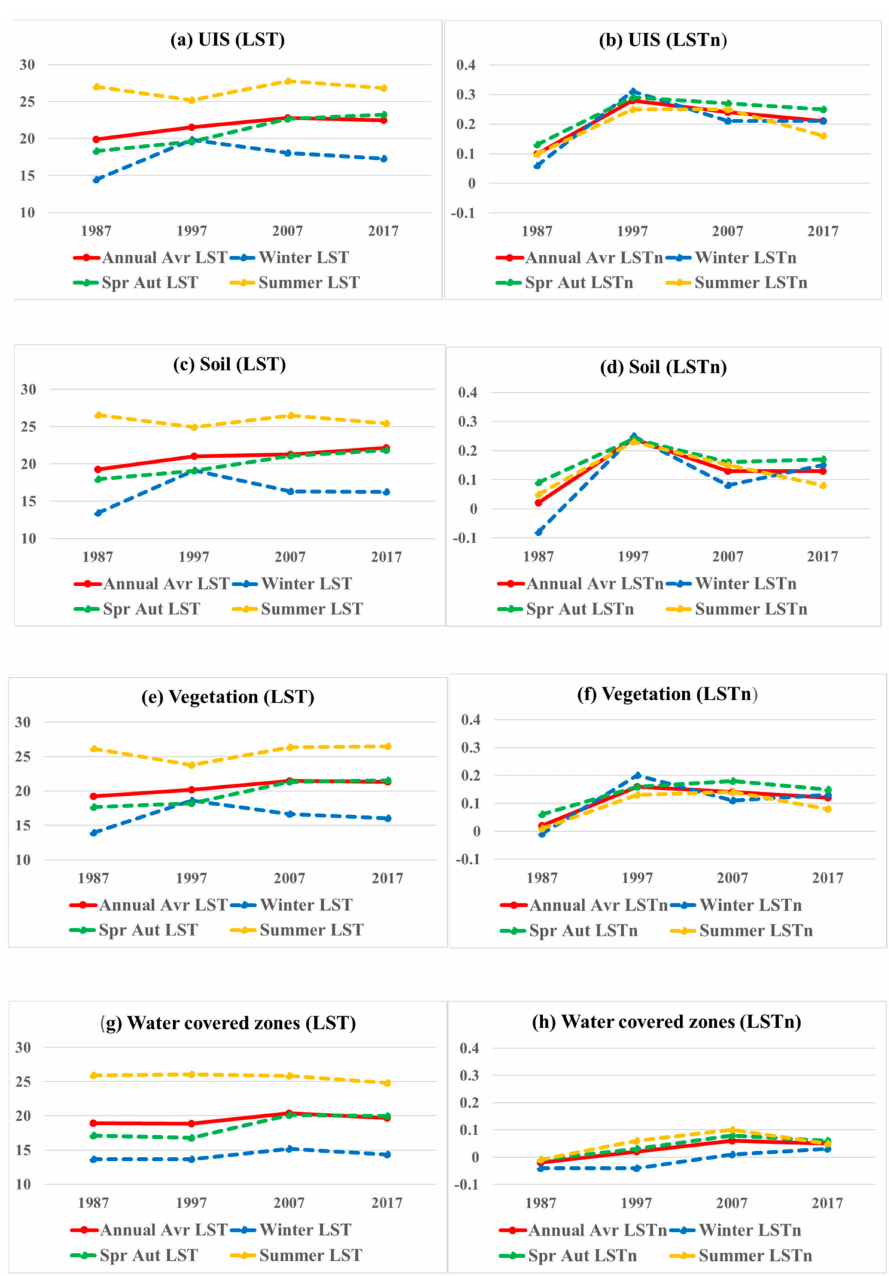
Figure 7. LST and LSTn of UIS, soil, vegetation, and inner water land cover